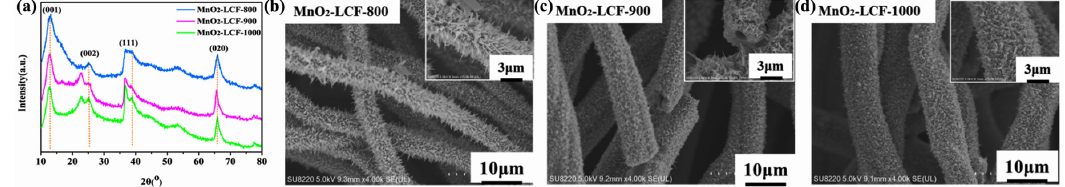
Figure 3. XRD patterns of the MnO 2 -LCF mats ( a ); SEM images of the MnO2-LCF-800 ( b ),